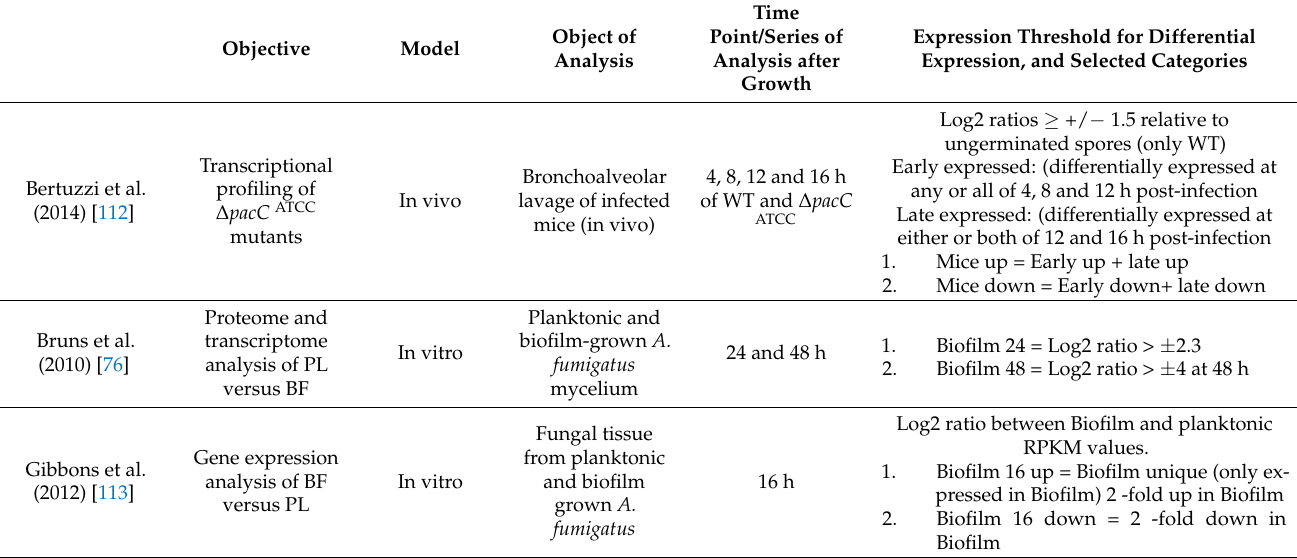
Table 2. Overview of gene expression studies of A. fumigatus biofilms. Whole genome expression studies of A. fumigatus biofilm growth were used to cross-reference with the PHI database [111]. No modifications of expression data or reanalysis of raw data was made in the case of Bertuzzi et al. 2014 and Gibbons et al. 2012 [112,113]. The data marked with bullet points was used to describe which genes were up- or down-regulated in that specific study. Expression thresholds for differential expression were kept as reported by the authors. Additionally, names of the categories used for Figure 2 are